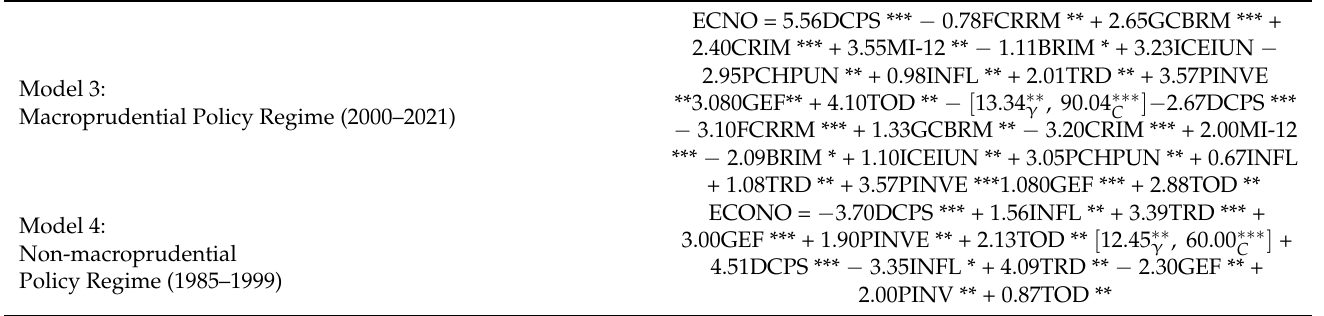
Table 4. Finance–Growth: Robustness Check